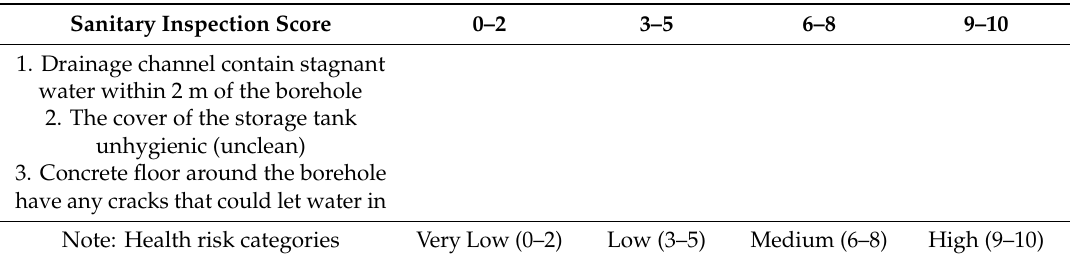
Table 1. Sanitary inspection survey questionnaire